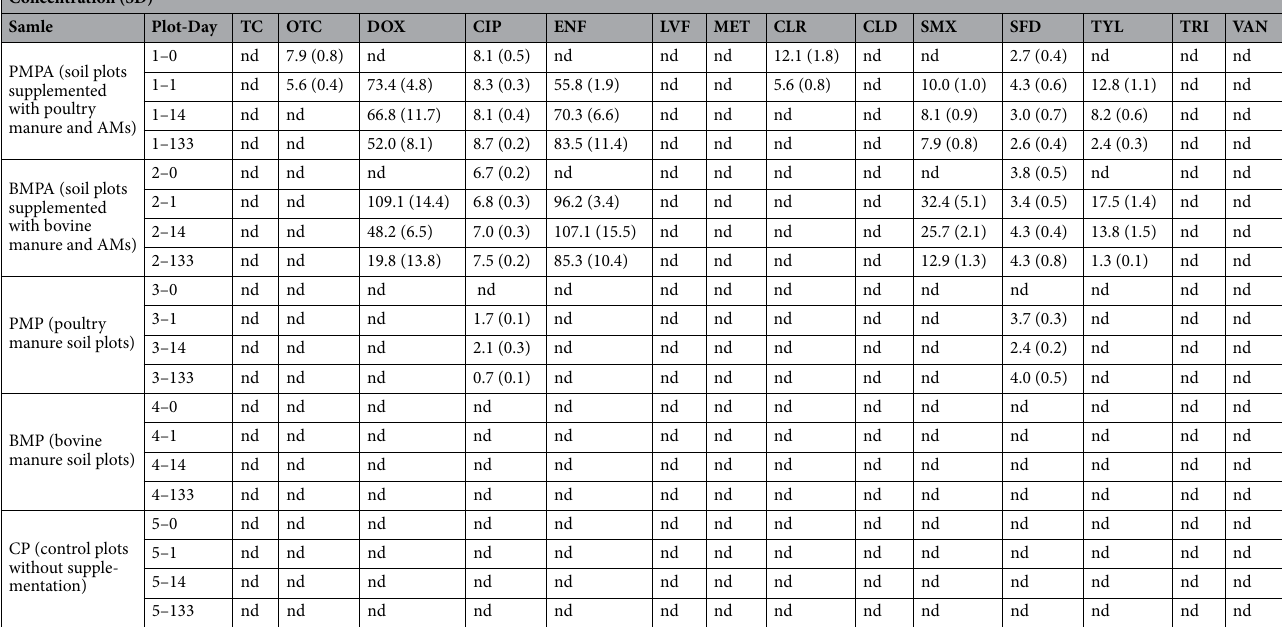
Table 3. Concentrations of selected antimicrobials in soil samples fertilized with manure (ng g −1 , dry weight). *nd—not